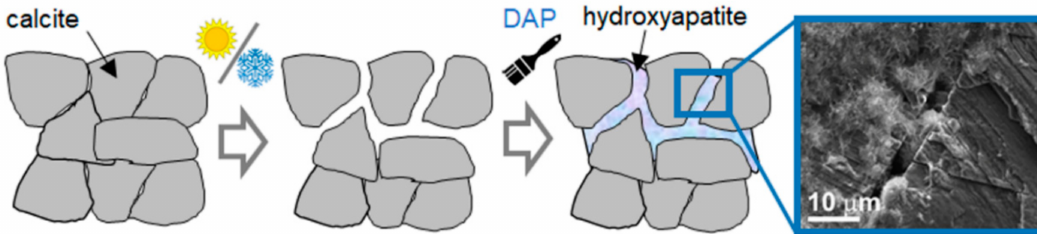
Figure 5. Scheme illustrating the consolidating action of the phosphate treatment, with an example of a SEM image showing HAP growth inside a crack in weathered